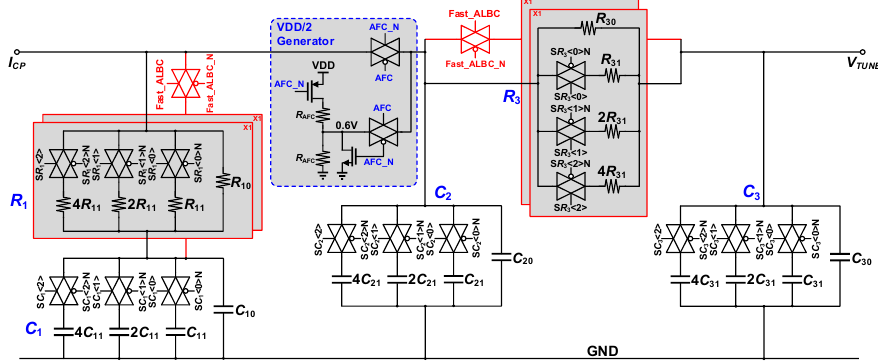
Figure 11. Programmable loop filter with embedded VDD/2 generation circuit.